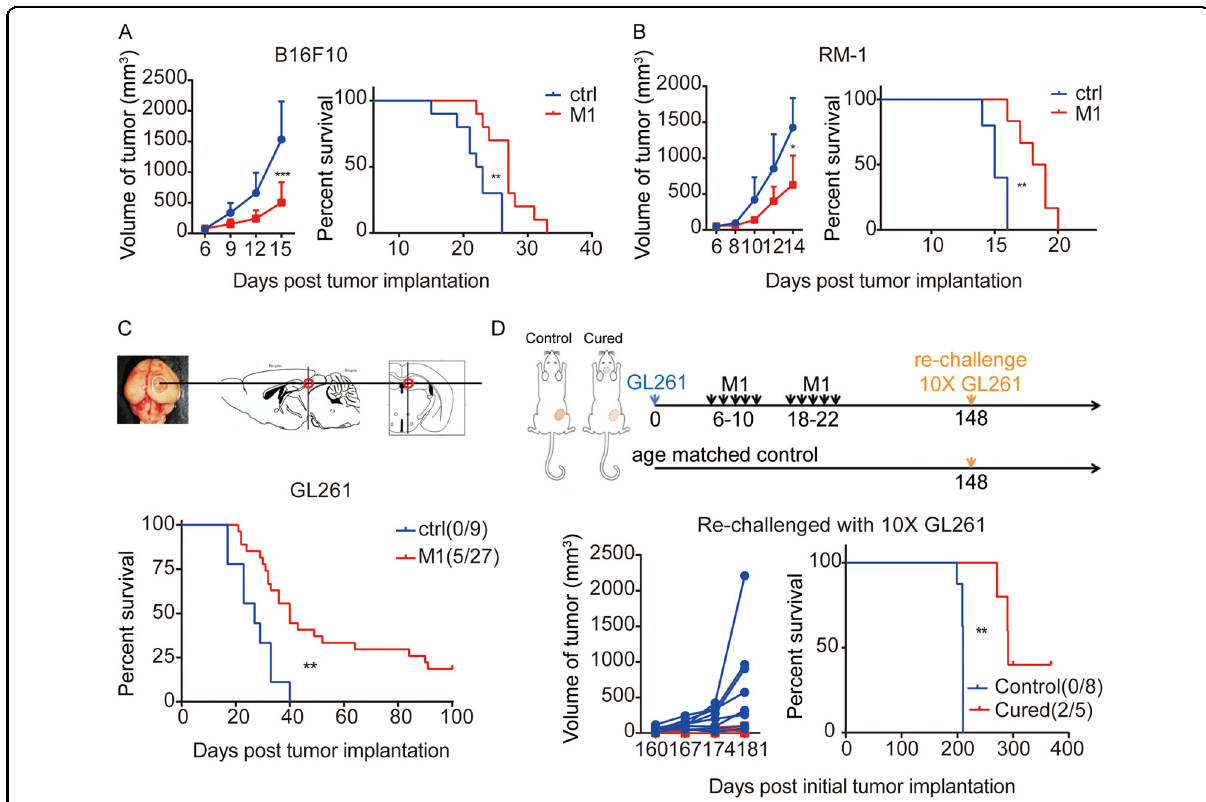
Fig. 1 Intravenous injection of M1 virus produces an antitumor therapeutic effect and establishes long-term protective immune memory in vivo. A C57BL/6J mice were implanted subcutaneously in the right fl ank with B16F10 cells on day 0 and treated intravenously with vehicle (ctrl) ( n = 10) or M1 ( n = 10) (1 × 10 7 plaque-forming units (pfu)) once per day on days 6 – 10. Tumor growth curves (left) and Kaplan – Meier survival curves (right) are shown. P values were determined by Student ’ s t test of the fi nal time point as indicated in graphs and log-rank test. B C57BL/6J mice were implanted subcutaneously in the right fl ank with RM-1 cells at day 0 and treated intravenously with ctrl ( n = 5) or M1 ( n = 6) (1 × 10 7 pfu) daily on days 6 – 10. Tumor growth curves (left) and Kaplan – Meier survival curves (right) are shown. P values were determined by Student ’ s t test analysis of the fi nal time point as indicated in the graphs and by the log-rank test. C Diagrammatic sketch of the mouse orthotopic glioma model. GL261 cells were inoculated 2 mm deep in the top right of the lambdoidal suture of the brain on day 0. The mice were injected with ctrl or M1 virus (1 × 10 7 pfu) via the tail vein once per day on days 6 – 10 and days 18 – 22. Long-term survivors (>100 days) are indicated. Kaplan – Meier survival curves are shown.